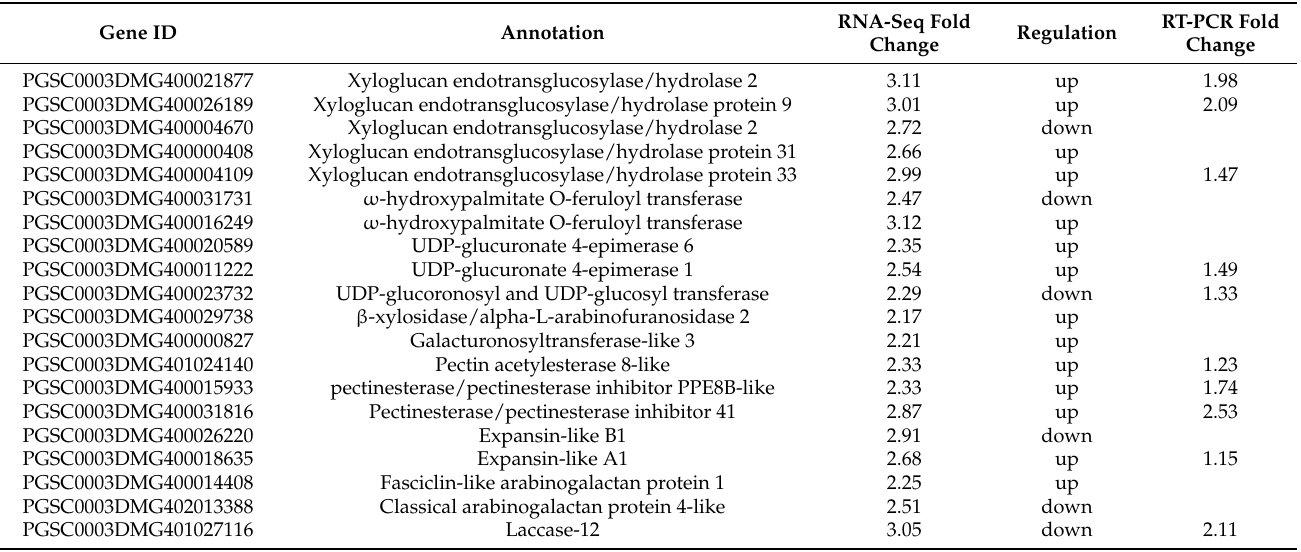
Figure 10. The most enriched GO terms of differentially expressed genes. Table 1. Differentially expressed genes on cell wall composition metabolism.